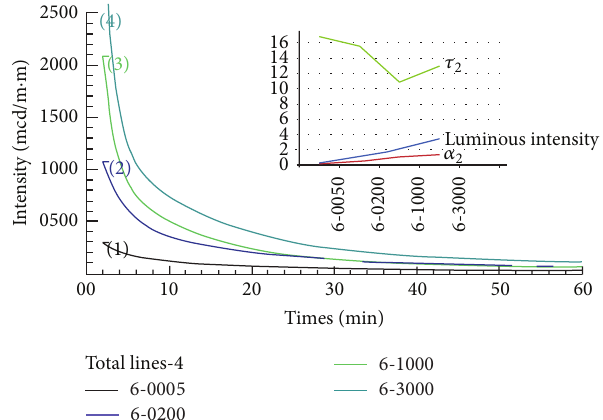
Figure 5: Afterglow profiles of the 0.6 mm thickness patch where the luminous intensity is measured at